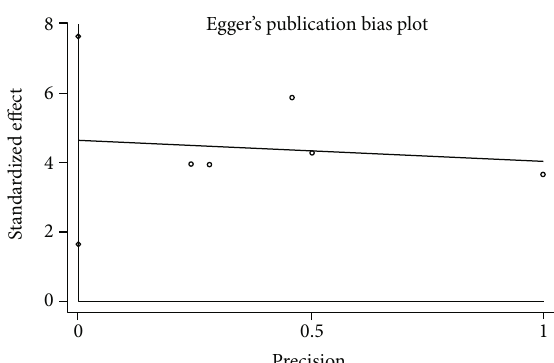
Figure 11: Publication bias of MRI signal score.